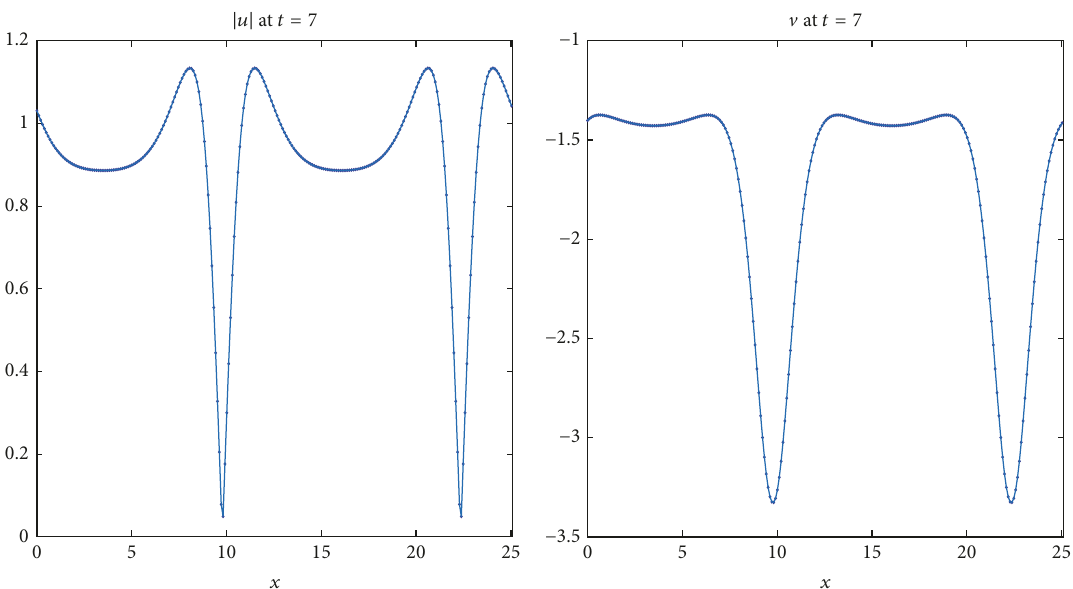
Figure 1: Approximations of the functions 𝜙,𝜓 in the travelling wave solution (39) with 9 Newton’s iterations. The model’s parameters are 𝛼 = 𝛽 = 𝛾 = 1 , 𝑤 = 1.5 , and wave speed 𝑐 = 0.5 and the fundamental period is 𝐿 ≈ 25.13 .